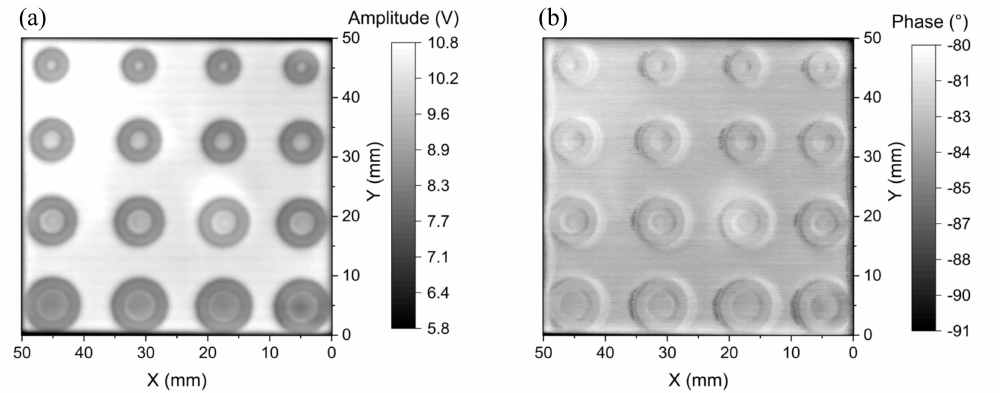
Figure 22. 2D images of ( a ) amplitude and ( b ) phase at the 40 kHz excitation frequency for the flaws buried at the second layer of the three-layer PCB